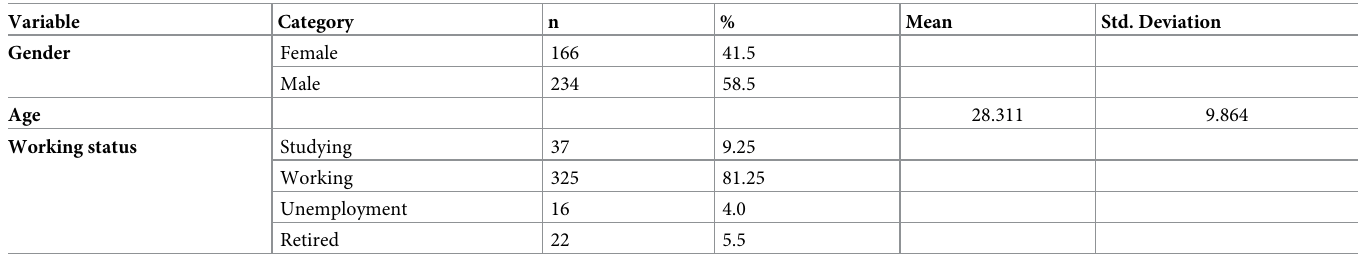
Table 2. Socio-demographic statistical descriptors of the respondents (n =